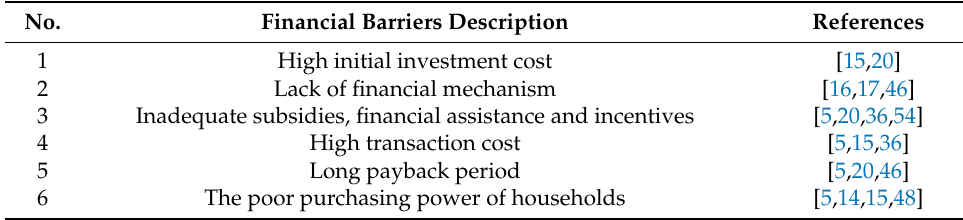
Table 2. Financial barriers for biogas adoption in